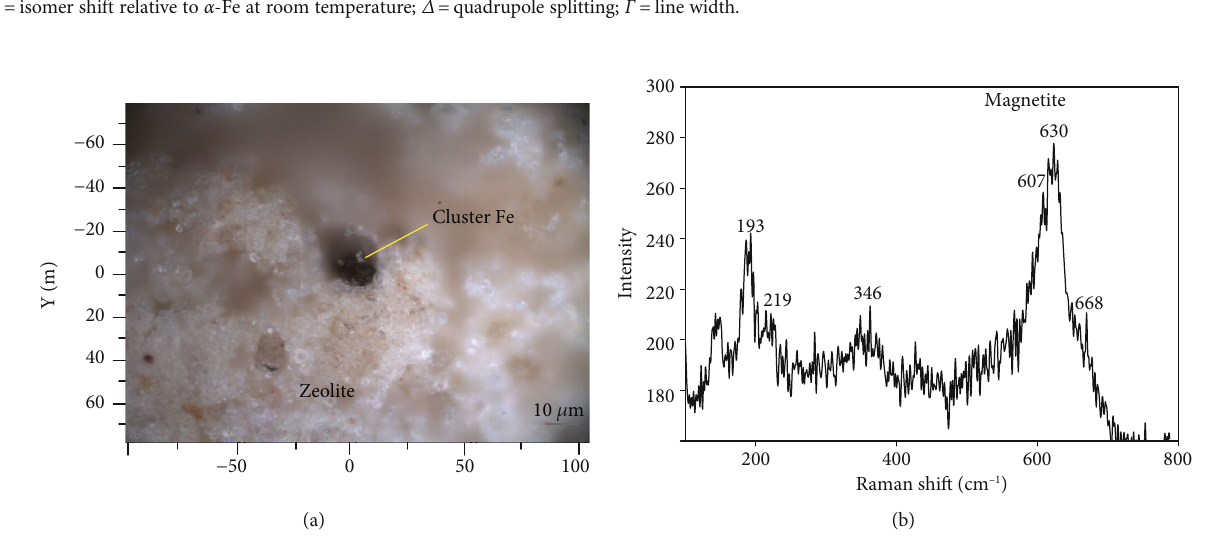
Figure 6: Raman spectrum for MNZ/Fe calcined at 700 ° C: (a) optic image and (b) micro-Raman